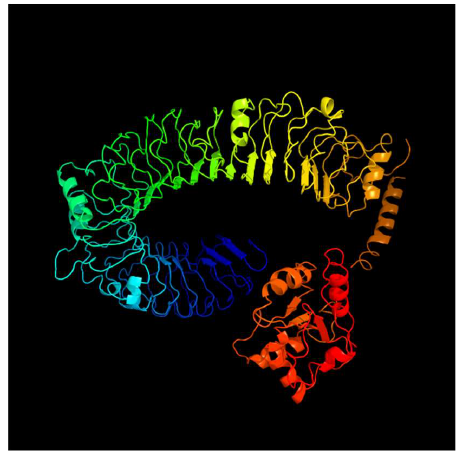
Figure 5. Predicted tertiary structure of tlr5s.